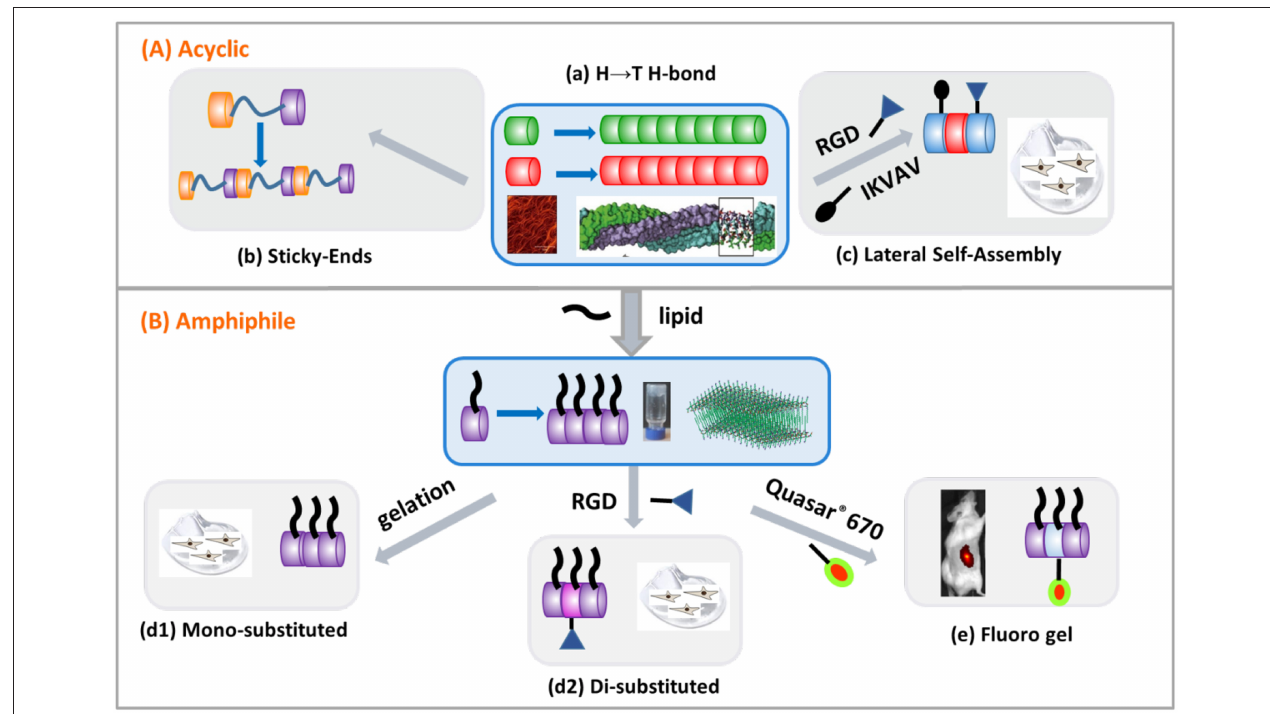
FIGURE 8 | Modular design of β 3 -peptide biomaterials by exploiting the head-to-tail (H → T H-bond) 3-point H-bonding motif. Monomers comprised of (A) acyclic β 3 -amino acids or (B) lipo- β 3 -amino acids. (A) (a) Template self-assembly motif, (b) sticky ends, and (c) controlled morphology through lateral interactions. (B) (d1) mono-substituted hydrogel, (d2) disubstituted hydrogel and (e) fluoro